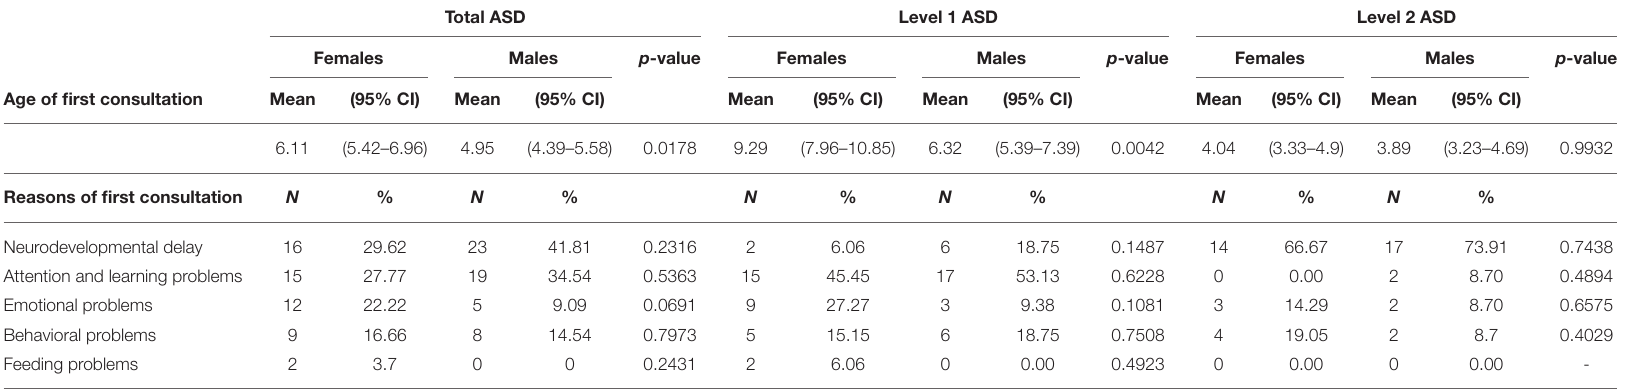
TABLE 2 | Age and Reason for first medical